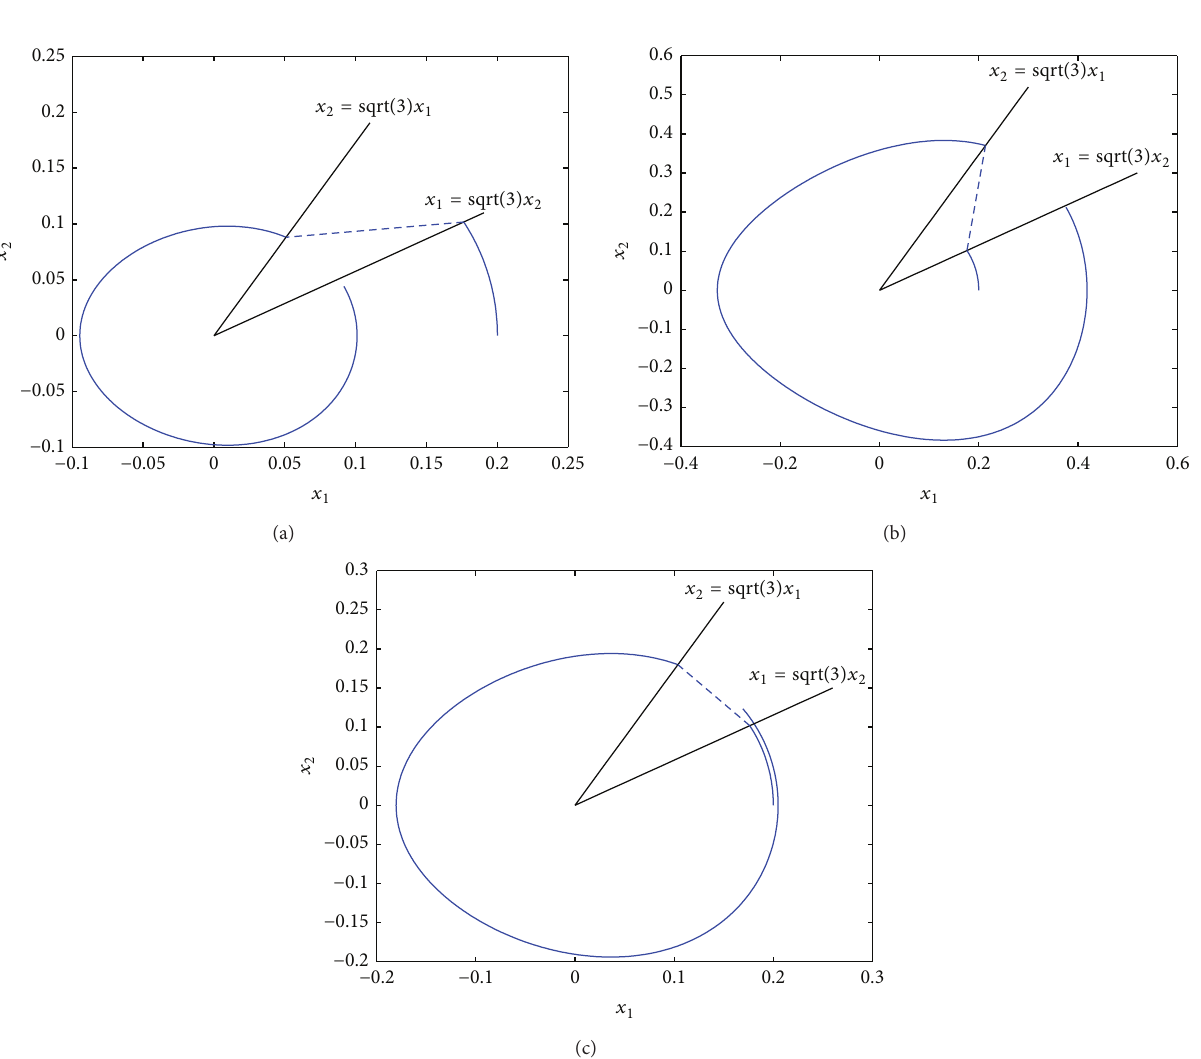
Figure 2: The focus of system (57a) and (57b). (a) A stable focus, where 𝑏 0 = 0.5 . (b) An unstable focus, where 𝑏 0 = 2.1 . (c) An unstable focus, where 𝑏 0 = 1